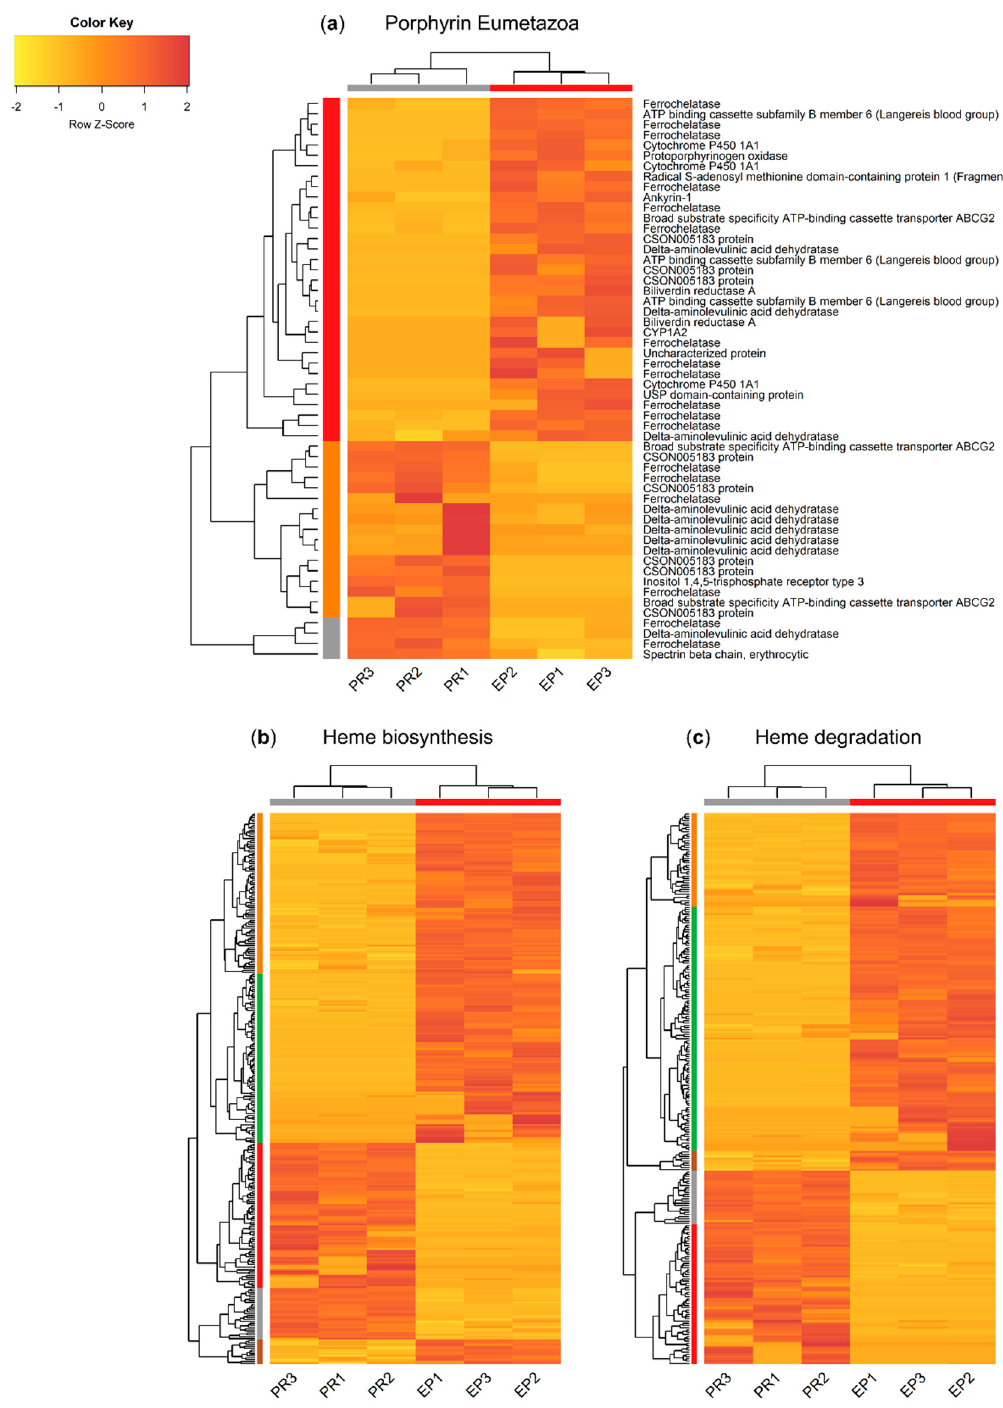
Figure 5. Heat maps illustrating the overall patterns of differentially transcribed mRNAs potentially pertaining to genes associated with the metabolism of tetrapyrroles and related compounds between the proboscis and epidermis of Eulalia . Separated by annotation subset retrieved from Uniprot. Three independent replicates (corresponding to three different individuals) per organ are represented (PR1-3 and EP1-3 for proboscis and epidermis, respectively). ( a ) “Porphyrin Eumetazoa”, ( b ) “heme biosynthesis”, and ( c ) “heme degradation”. Horizontal and vertical dendrograms plus sidebars represent clustering of biological replicates and genes, respectively. The criteria for the selection of DEGs were significant homology-matching ( e -value < 10 − 5 ), FDR-adjusted p ≤ 0.05, and |logFC| > 2. Expression levels were row-normalized and are given as transcripts per million (TPM) and plotted as a color gradient from yellow (lowest) to red (highest). Cluster analysis was based on Euclidean distances as metric and dendrograms were built using complete linkage.